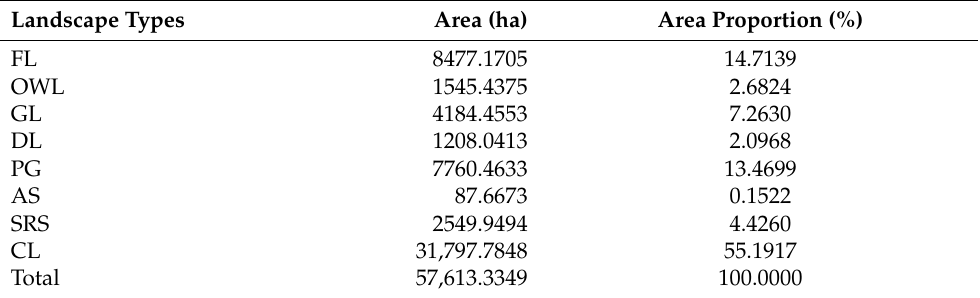
Table 6. Area and area percentage of various types of riverfront greenspaces in the holistic river buffer